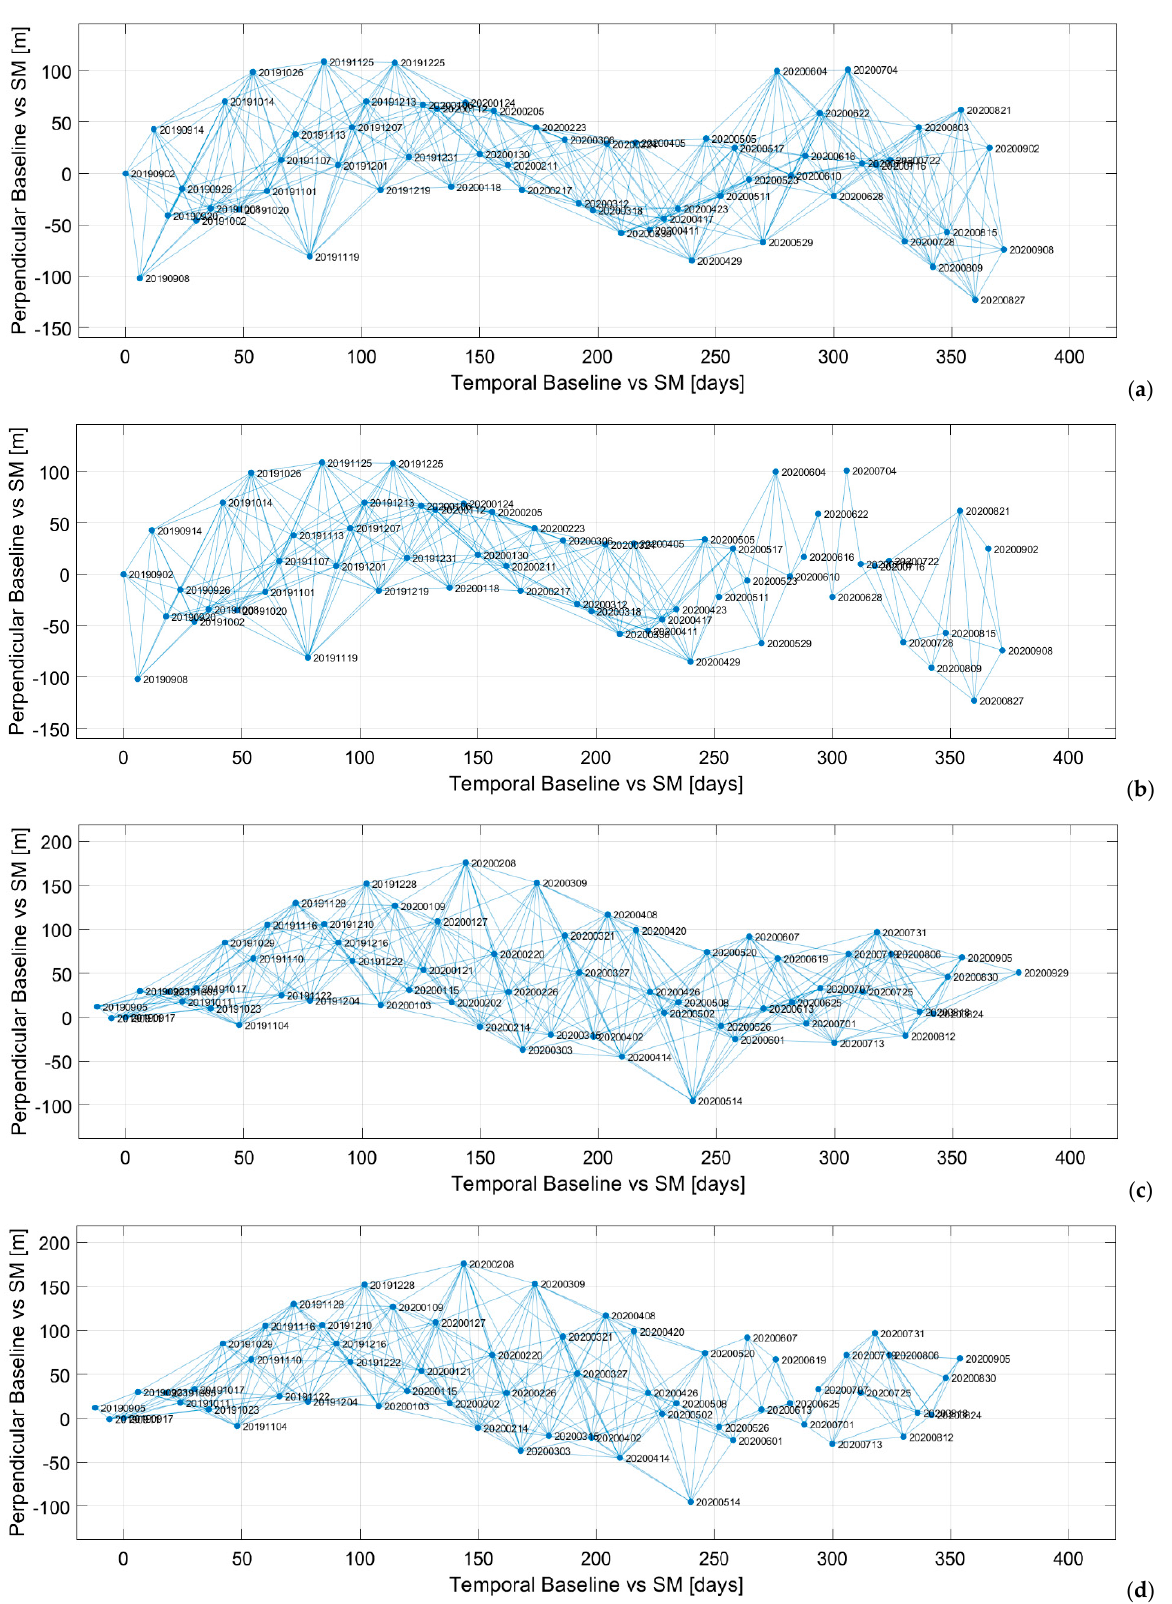
Figure 3. Small baseline interferogram network, full ( a ) and reduced ( b ) for Sentinel-1 ascending data, full ( c ) and reduced ( d ) for descending data, represented in the plane given by the temporal/perpendicular baselines with respect to the Super-Master image.